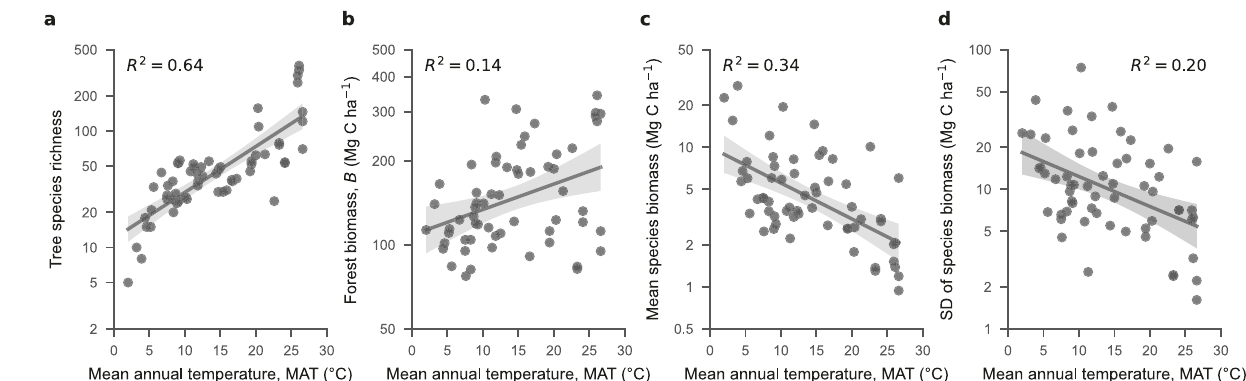
Fig. 3 | Forest structural measures in relation to mean annual temperature (MAT)among60plotsineasternAsia.a Treespeciesrichness(i.e.,speciescount per plot); b aboveground forest biomass B ; c mean species aboveground biomass; d standard deviation of species aboveground biomass. The regression line in each